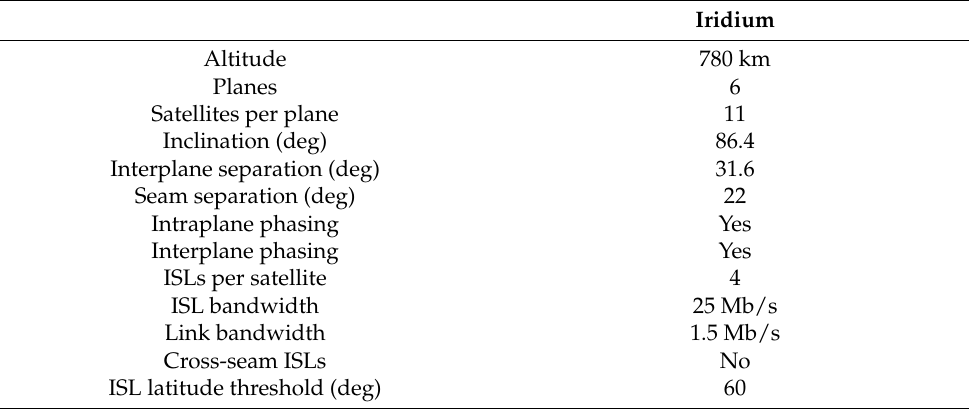
Table 4. The detailed parameters of Iridium